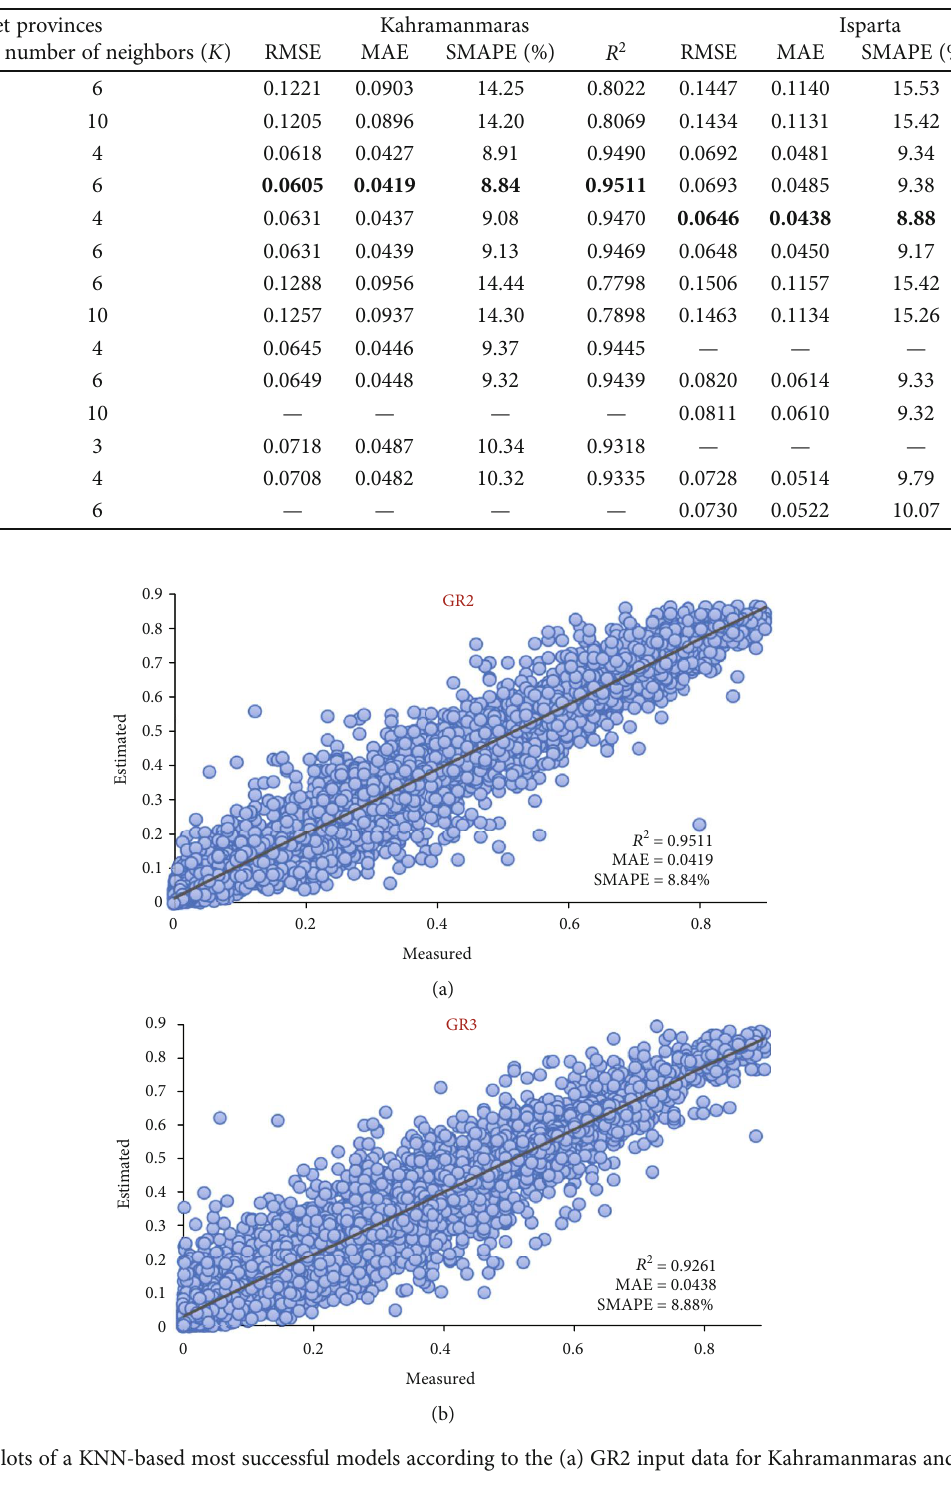
Table 10: Estimation results of the two most successful models that were developed by using a KNN algorithm according to input data groups of both